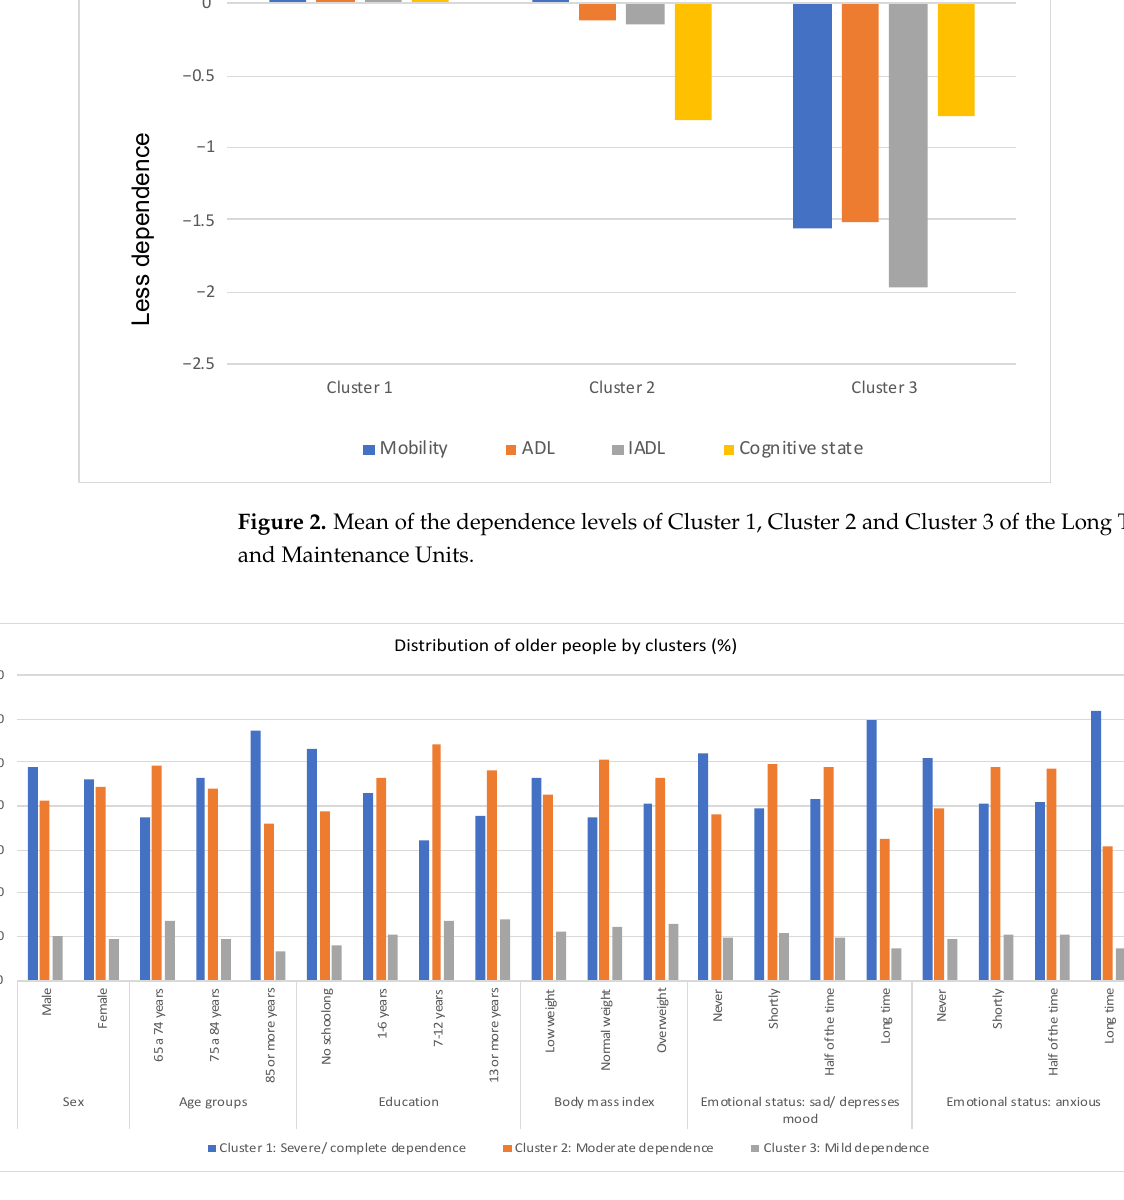
Figure 3. Distribution of the people aged 65 years or older in the Long Term Care and Maintenance Units by sex, age groups, educational level, body mass index, emotional state: sad/depressed and emotional state: anxious, per cluster.